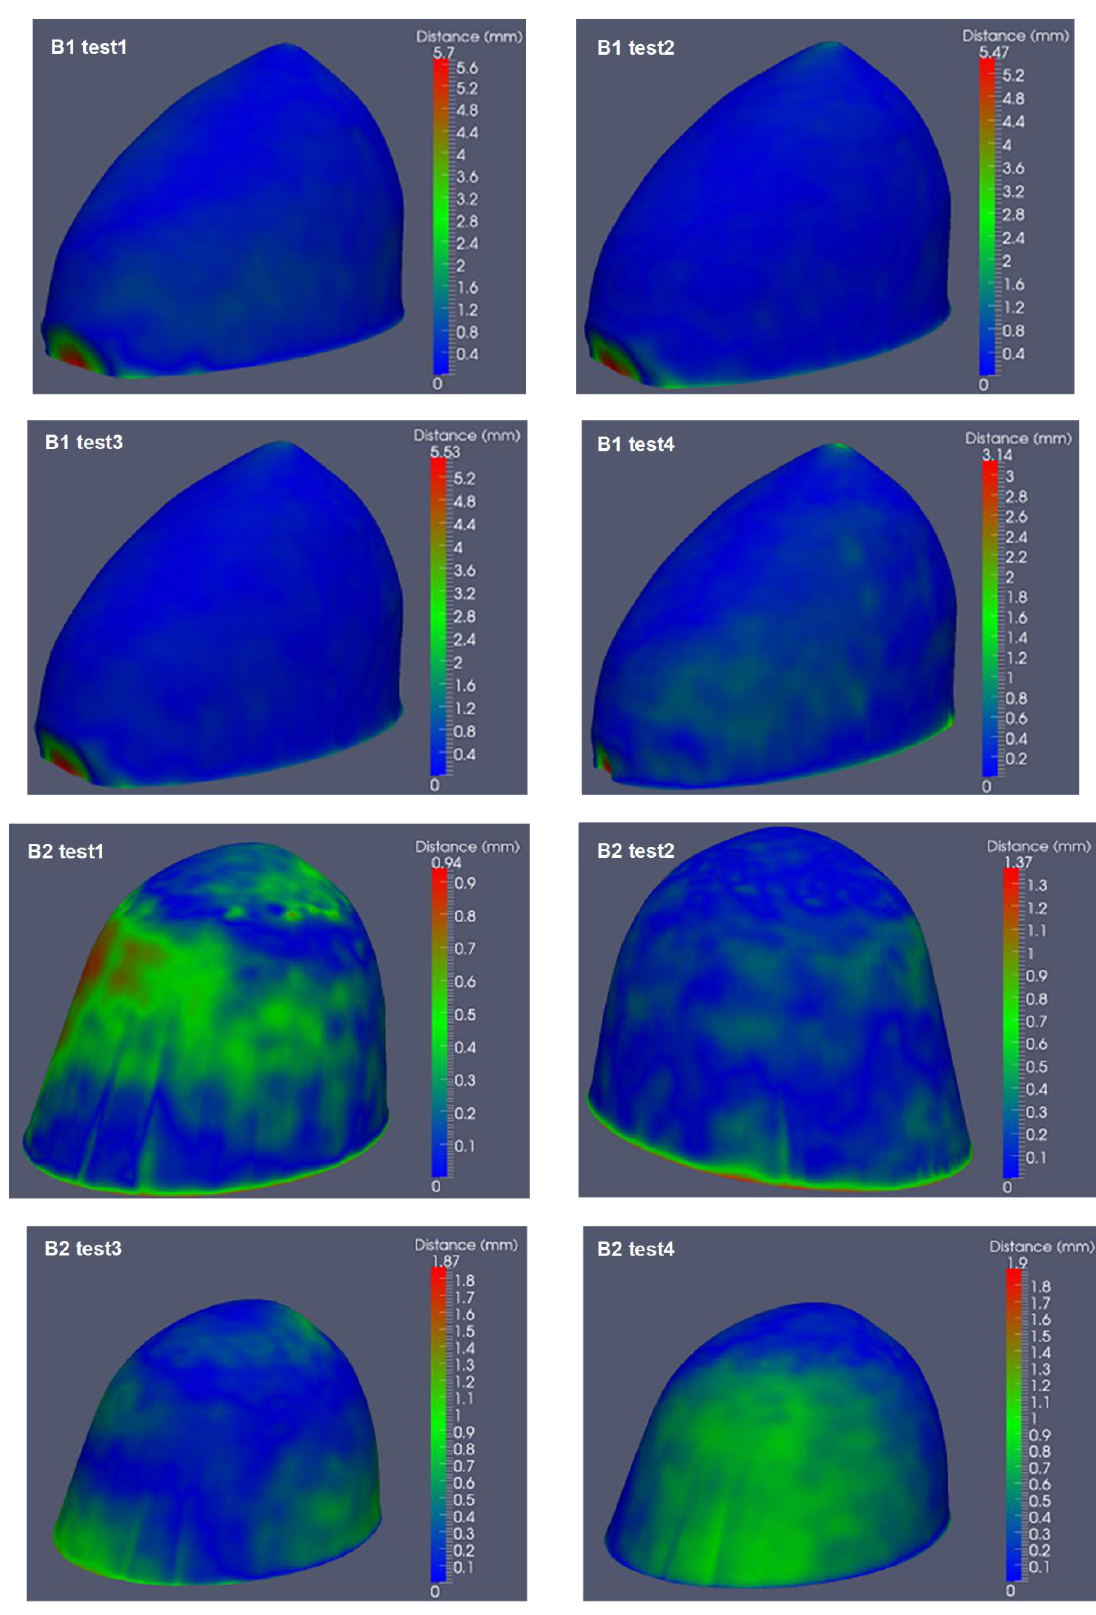
Figure 32. Breast distance color maps for B1 and B2 extracted breast surfaces: multiple scans used for the evaluation of the surface reconstruction of either of the two test breast phantoms.